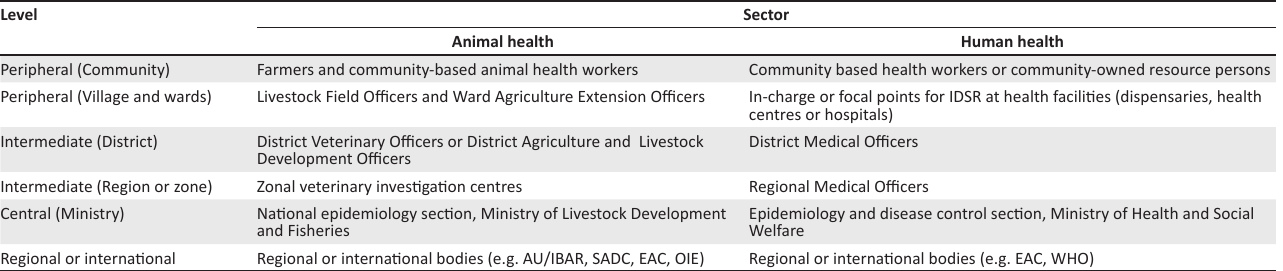
TABLE 1: Similarities between disease surveillance structure in animal and human health sectors in Tanzania.